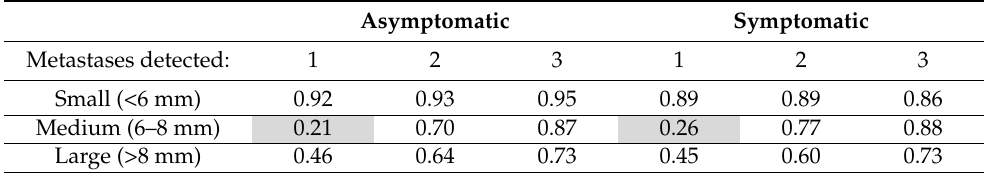
Table A16. Proportion of oligo+ within patients with detected oligo-metastases in the Metastatic metastases 50% scenario.